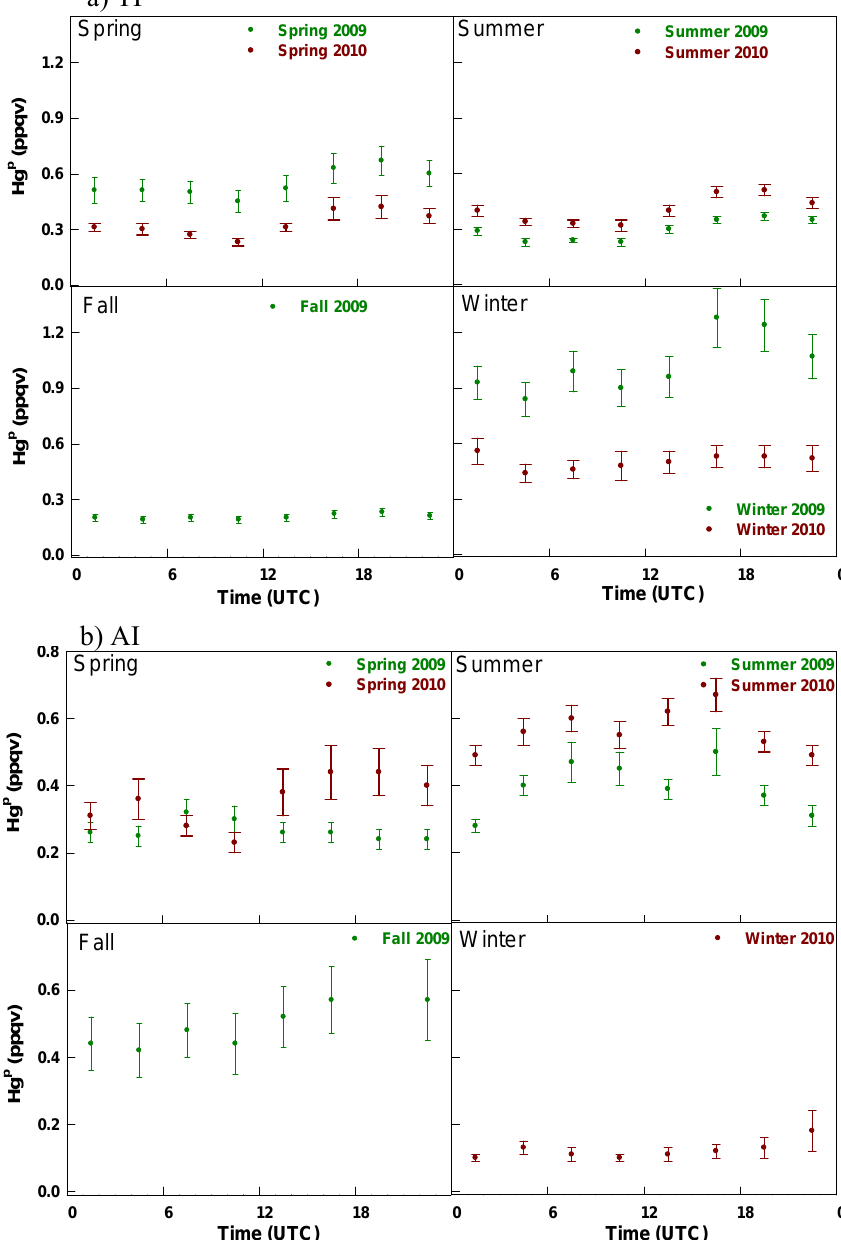
Fig. 10. Seasonally averaged diurnal cycles of Hg P with standard deviation of means at TF (a) and AI (b) . was driven by oxidation while the total effect of deposition and oceanic emissions is similar in night- and